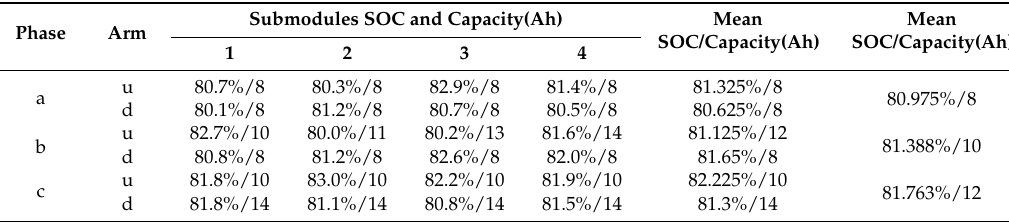
Table 2. The initial SOCs and capacity of the 24 battery